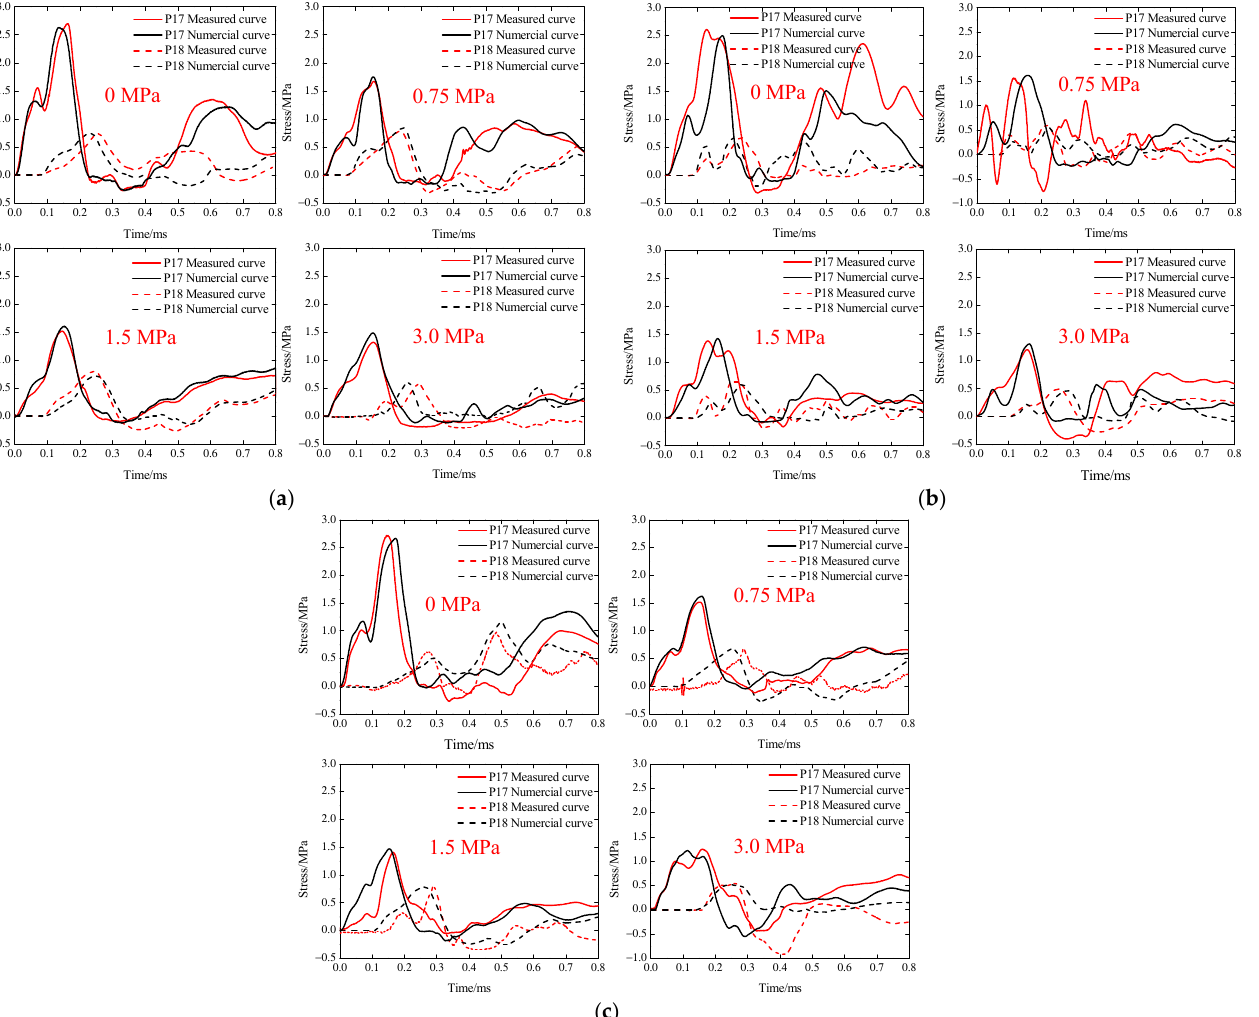
Figure 9. Measured and numerical stress wave curve at P17 and P18 points in each sample under different static loads: ( a ) T1 sample; ( b ) T2 sample; ( c ) T3 sample.